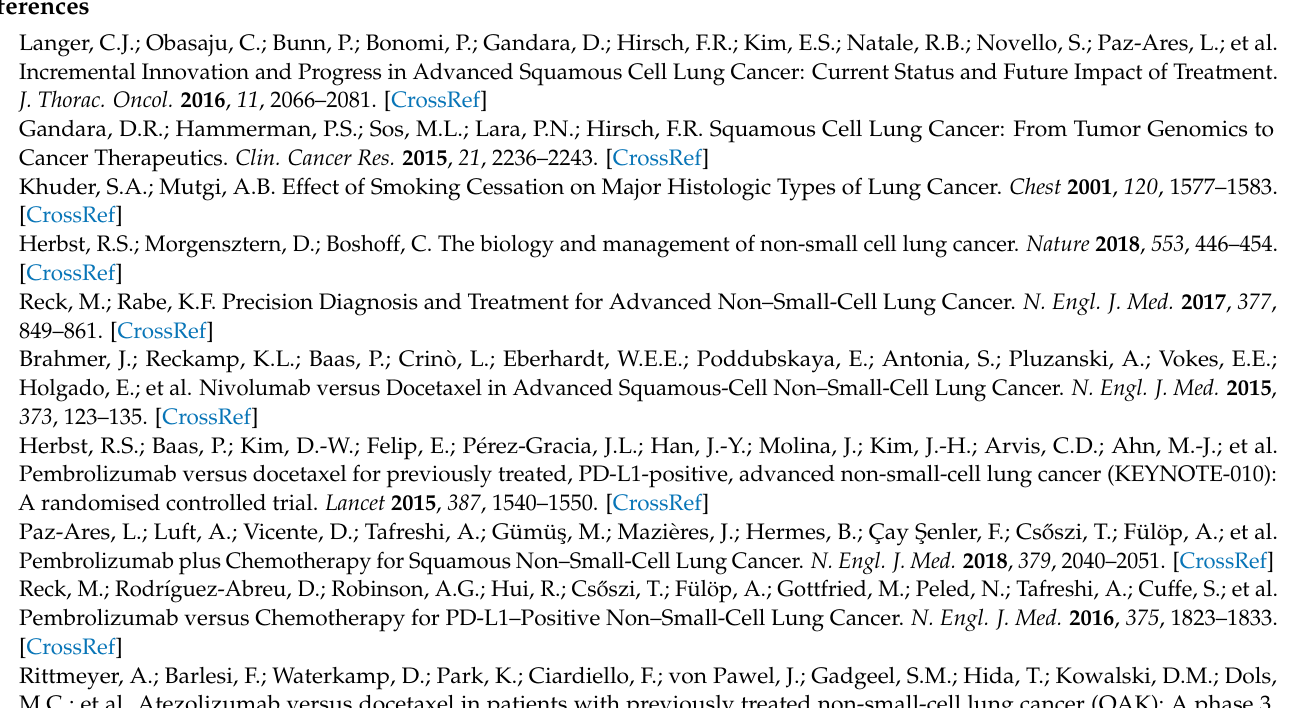
pathway; Supplementary Figure S8: Both LRP1B and TP53 mutation were associated with higher TMB; Supplementary Figure S9: The somatic copy-number alteration profile among TP53 / LRP1B co-mutation, TP53 mut / LRP1B wild and TP53 wild / LRP1B mut LUSC. Supplementary Figure S10: The results of GSEA analysis base on hallmark gene set. Supplementary Table S1: Detailed List of the 1021-gene-panel in Geneplus cohort; Supplementary Table S2: The mutated genes of 525 patients in Geneplus cohort; Supplementary Table S3: The clinical information and PD-L1 expression data of Geneplus cohort; Supplementary Table S4: Clinical characteristics of the 525 patients in Geneplus cohort; Supplementary Table S5: 358 significantly upregulated genes in TP53 / LRP1B co-wild type. Supplementary Table S6: 275 significantly upregulated genes in TP53 / LRP1B mutant type. Author Contributions: Conceptualization, L.L. and J.Y.; formal analysis, Z.Z., J.Y. and Z.F.;